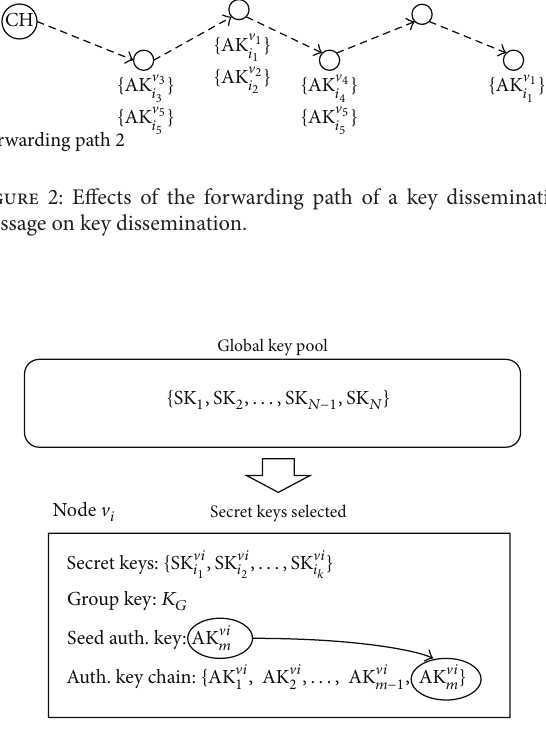
Figure 3: Predistribution of a seed authentication key and secret